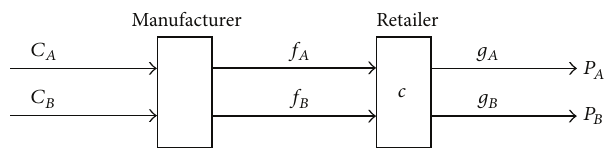
Figure 1: The structure of renewal products